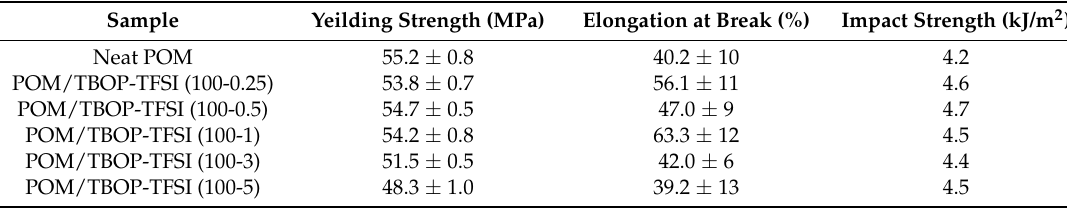
Table 2. Mechanical properties of POM/TBOP-TFSI composites.